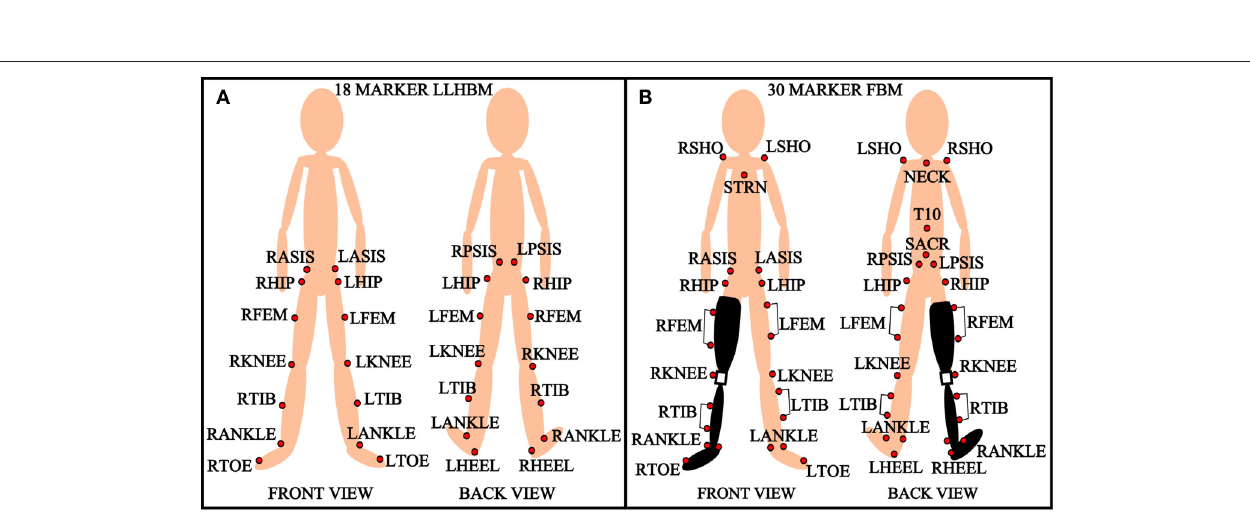
Frontiers in Neurorobotics | www.frontiersin.org